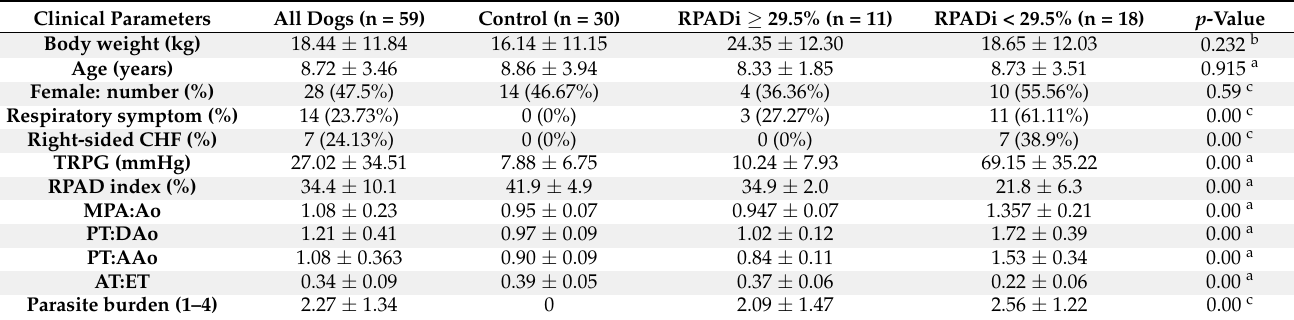
Legend: Results for body weight, age, tricuspid pressure gradient (TRPG), right pulmonary artery distensibility index (RPAD index), main pulmonary artery to aorta ratio (MPA:Ao), pulmonary trunk to descending aorta ratio (PT:DAo), pulmonary trunk to ascending aorta ratio (PT:AAo), right acceleration time to ejection time ratio (AT:ET) and parasite burden are expressed as mean ± standard deviation. Results for female, respiratory symptoms, and right sided congestive heart failure (CHF) are expressed as n (%). p values: a p < 0.01 = ANOVA;